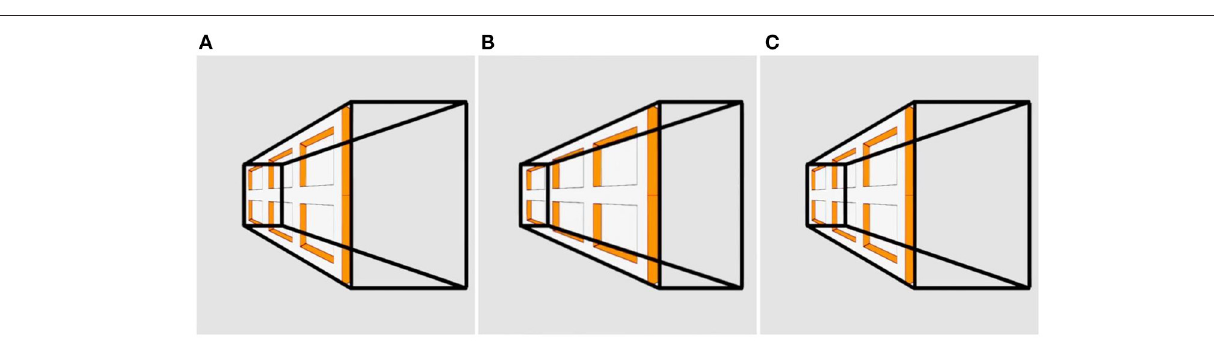
FIGURE 6 | The Ames Prism. This rotating trapezoidal prism ( = truncated pyramid) is textured on one side with an image of the Ames window. Panels (A) and (C) are identical, while panel (B) contains disparity. Please see Supplementary Video 6 for an